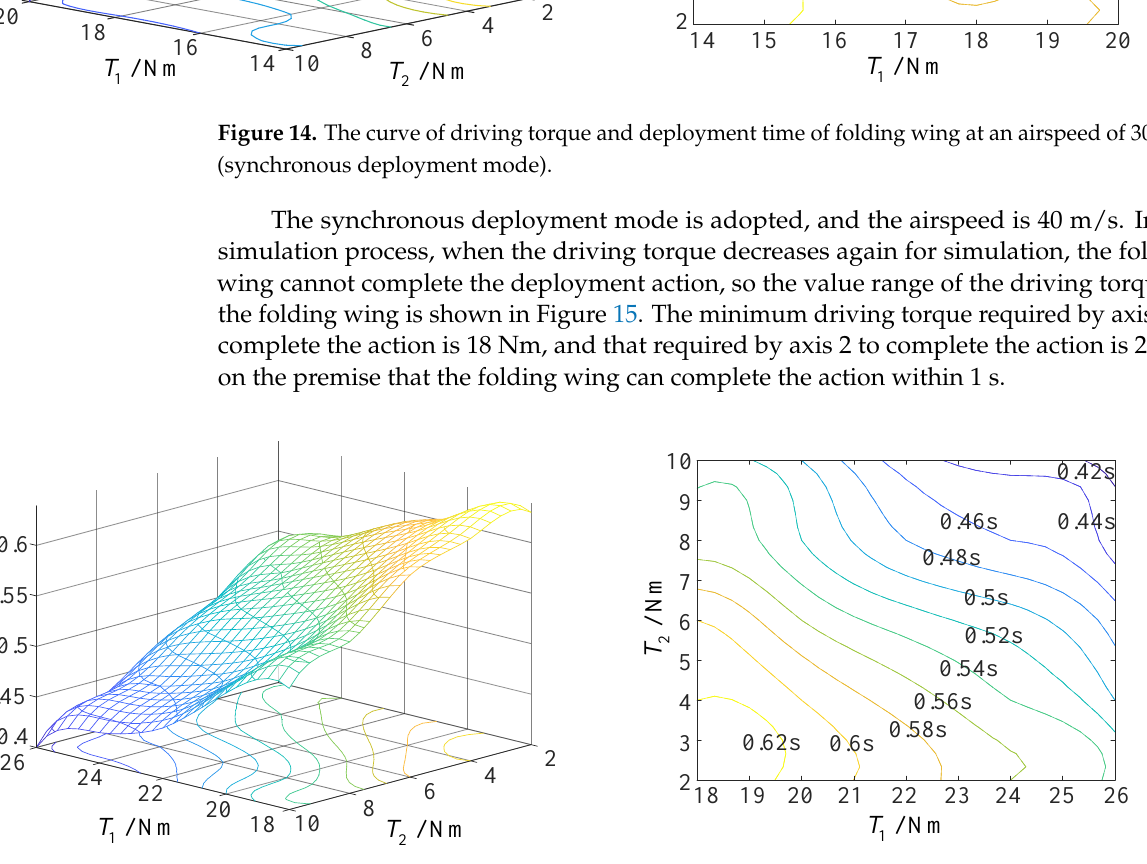
Figure 16. The curve of driving torque and deployment time of folding wing at an airspeed of 10 m/s (non-fixed-axis – fixed-axis stepwise deployment mode). When the non-fixed-axis – fixed-axis stepwise deployment mode is adopted and the airspeed is 20 m/s, the minimum driving torque required by axis 1 to complete the action is 16 Nm, and that required by axis 2 to complete the action is 22 Nm, on the premise that the folding wing can complete the action within 1 s, as shown in Figure 17.